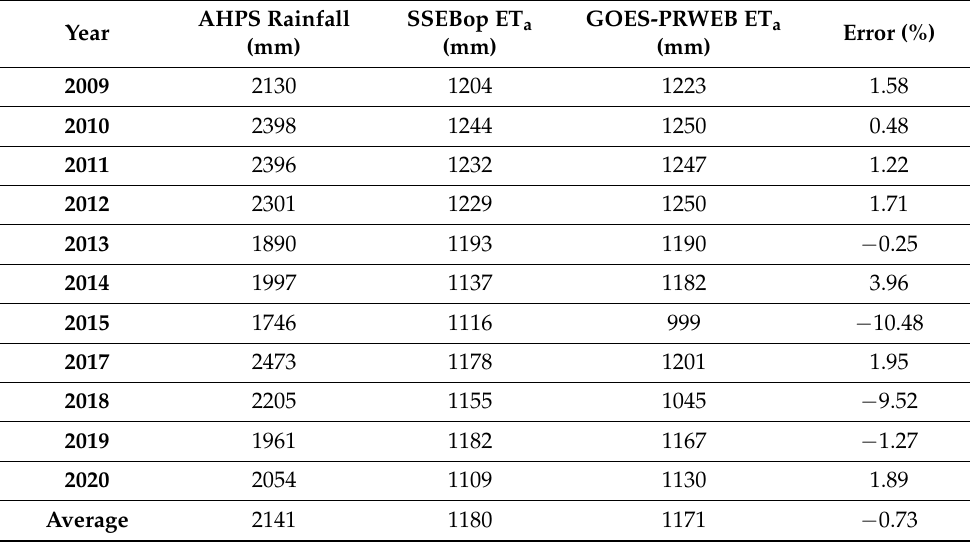
Table 3. Comparison of SSEBop and GOES-PRWEB annual ETa for 2009–2020.